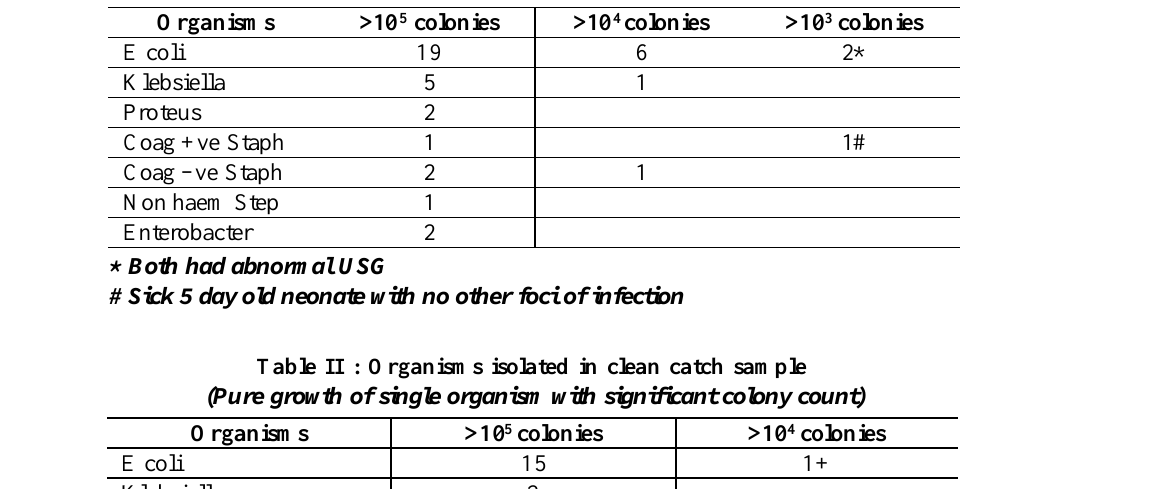
Table III : Organisms isolated in SPA sample